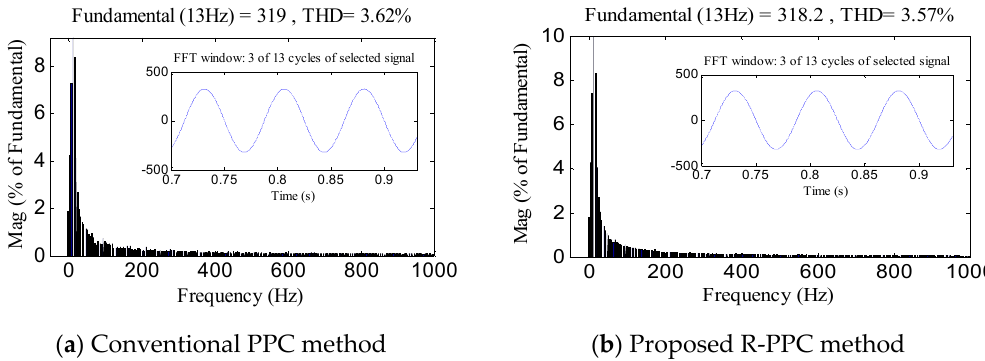
Figure 10. Stator current frequency spectra of the 6*3-phase PMSM under the charge state. ( a ) Conventional PPC method; ( b ) Proposed R-PPC method.